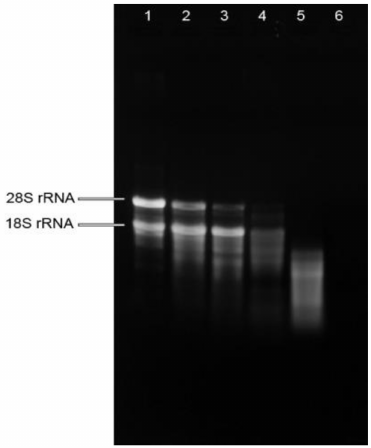
Figure 1. Quality assessment of total RNA isolated from mistletoe preparations by agarose gel electrophoresis. Lane 1: RNA isolated from fresh plant (FP); Lane 2: RNA isolated from mistletoe extract made from FP; Lane 3: RNA isolated from mistletoe extract made from FP treated with mechanical treatment; Lane 4: RNA isolated from dried mistletoe plant (DP); Lane 5: RNA isolated from mistletoe extract made by soaking DP in 80 ◦ C water for 10 min; Lane 6: RNA isolated from mistletoe extract made by boiling DP for 30